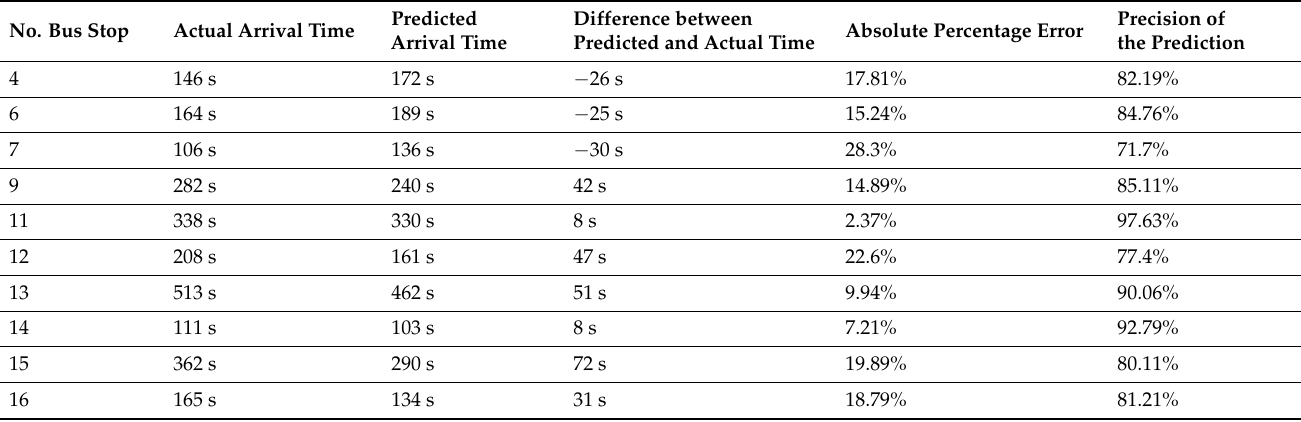
Table 3. Results obtained for Trip 2, Journey: Guacamayas–University. MAE = ± 34 s, MAPE = 15.7% Precision =